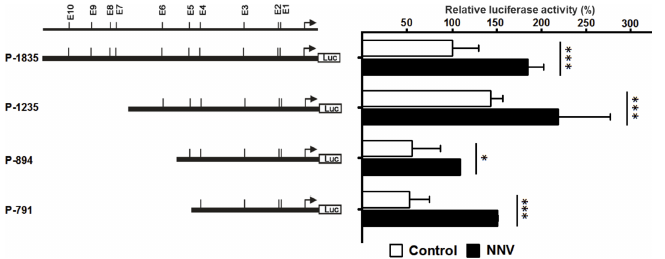
Fig 5. Effect of NNV infection on the myostatin promoter activity. The transfected Gf-1 cells were infected by a titter of 10 4 TCID 50 /ml of isolatedGNNV. The relative luciferaseactivity of constructs P-1835, P- 1235, P-894 and P-791 were measuredat 24 hours post-infection and normalized againstthe activity of the pGL3-Basic vector. Bars indicate averages ± standarddeviationsfor three replicateexperiments and asterisks show significantdifferences( * p <